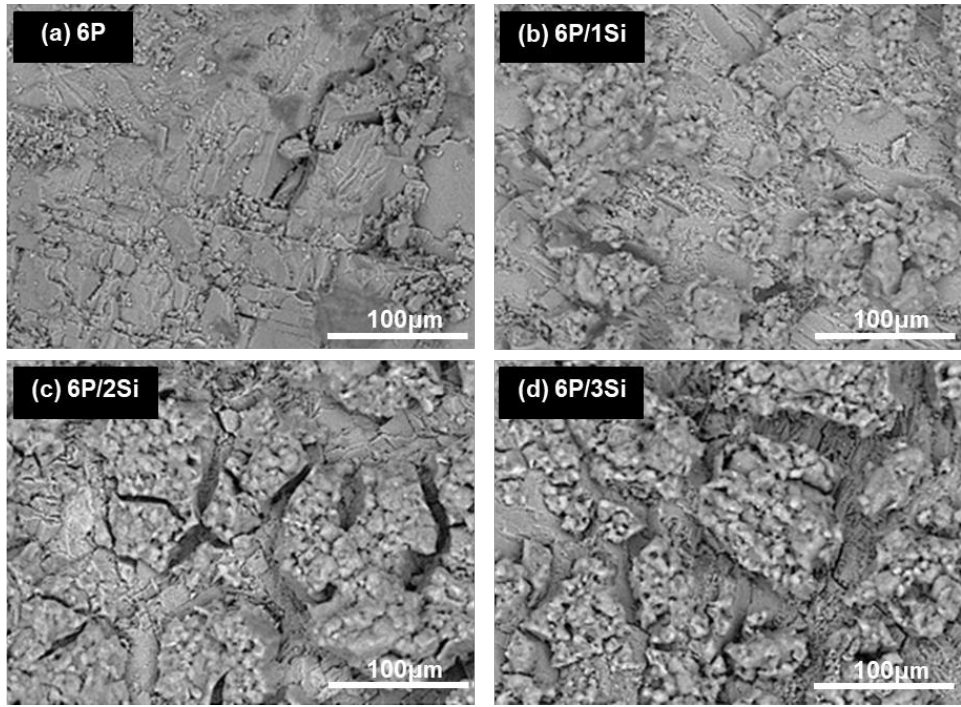
Figure 3. Surface structures of the 6P-based coatings, which were prepared using ( a ) no NPs ( b ) 1, ( c ) 2 and ( d ) 3% w / w NP concentration. Fluoropolymer F was not included. ( c ) 2 and ( d ) 3% w / w NP concentration. Fluoropolymer F was not